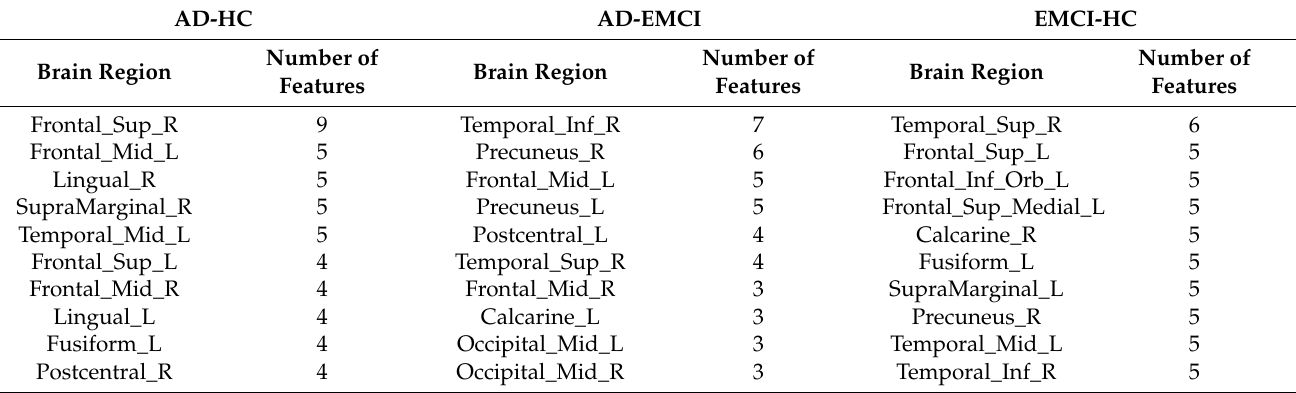
Table 2. The top 10 brain regions with the most features.